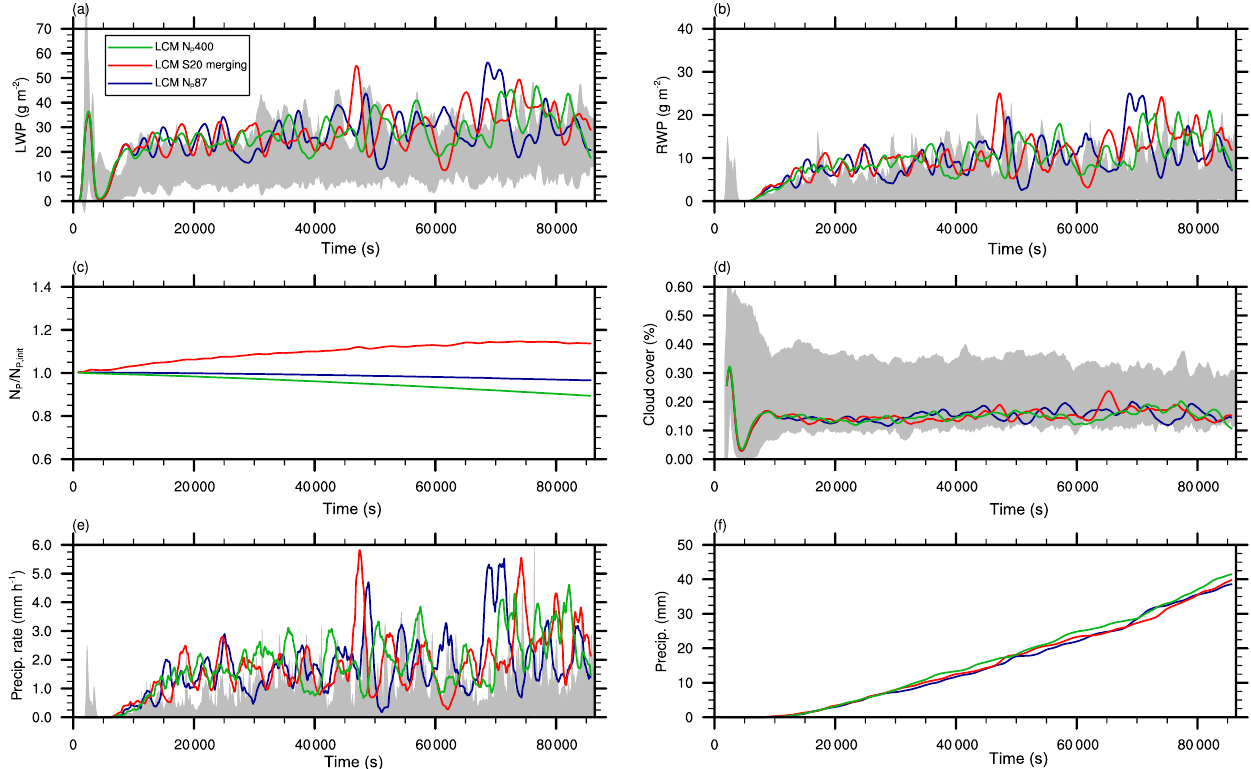
Figure 17. Time series of (a) the liquid water path (LWP), (b) rainwater path (RWP), (c) ratio of the actual number of superdroplets to the initial number of superdroplets, (d) cloud cover, (e) precipitation rate, and (f) total precipitation for different initial numbers of superdroplets and splitting configurations. The gray areas in (a) , (b) , and (d) indicate the documented model variability in the simulated shallow cumulus case (vanZanten et al.,